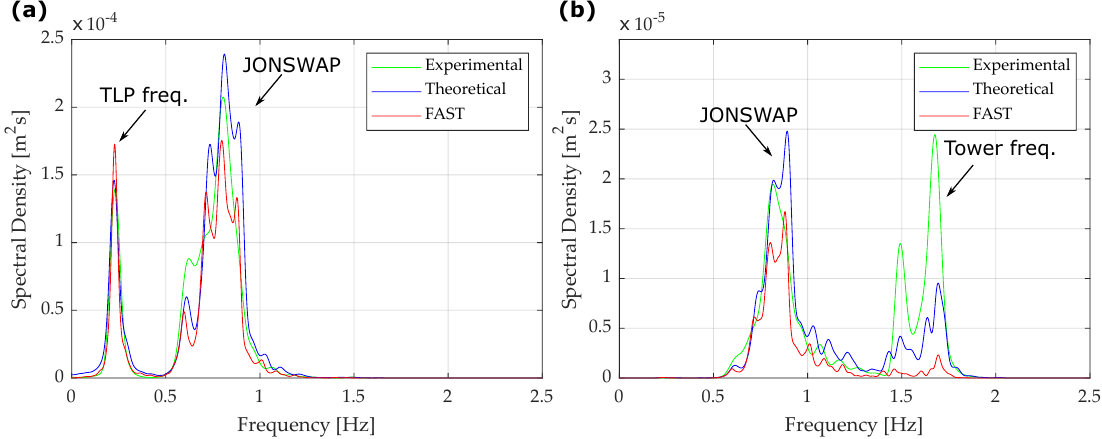
Figure 8. ( a ) The PSDs of the displacement of the TLP, when exposed to waves generated from a scaled down JONSWAP wave spectrum. ( b ) The PSDs of the displacement of the tower top, when exposed to waves generated from a scaled down JONSWAP wave spectrum.